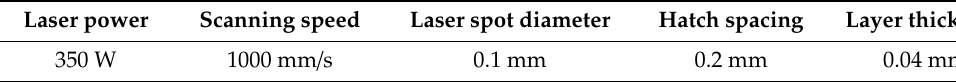
Table 1. Chemical composition of INCONEL 718 alloy (IN718) powder (mass fraction: %). Element